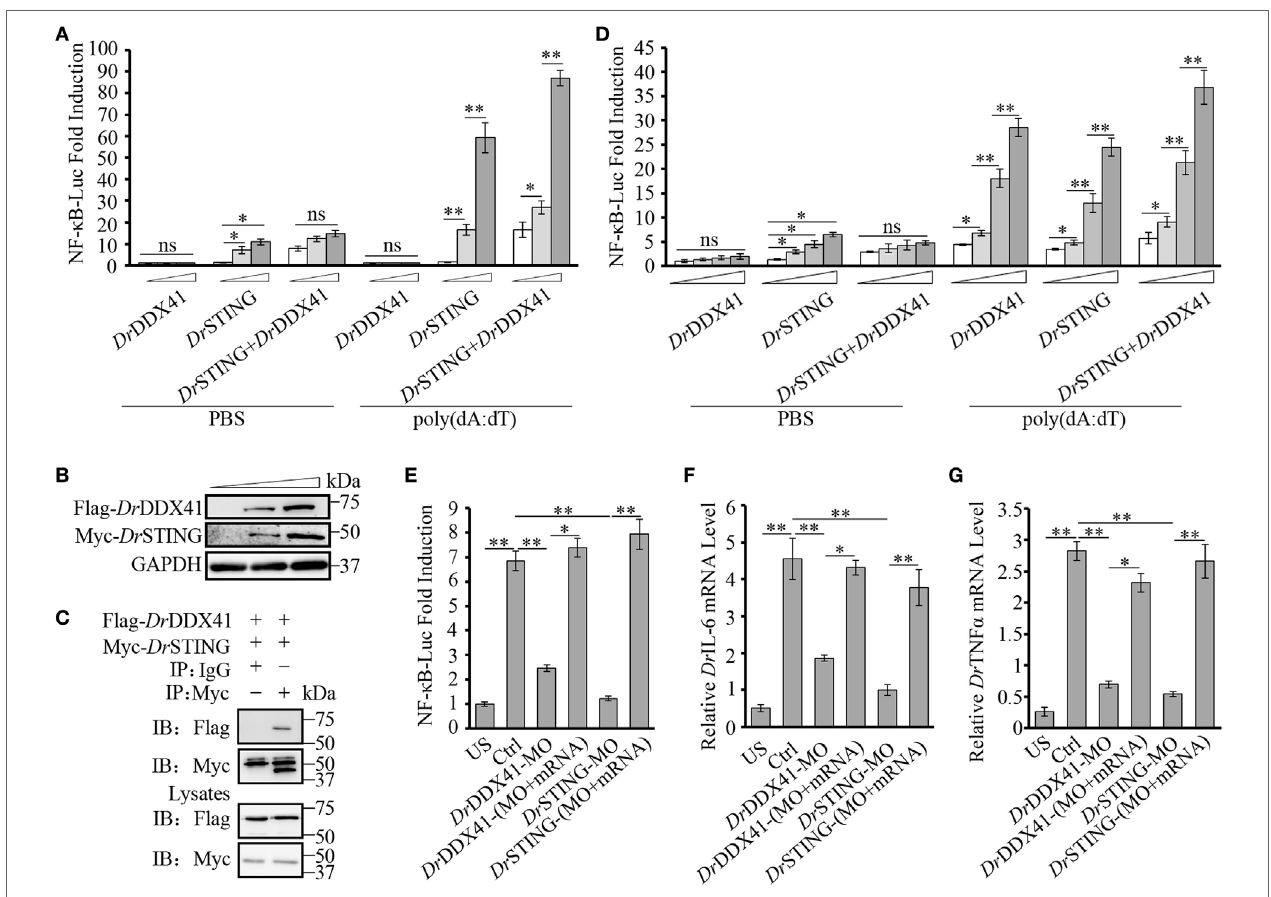
FigUre 6 | Involvement of Danio rerio DDX41 ( Dr DDX41) in nuclear factor- κ B (NF- κ B) signaling pathway. (a) Activation of the NF- κ B-binding promoter in HEK293T cells transfected with an NF- κ B luciferase reporter (NF- κ B-Luc; 150 ng/mL), a renilla luciferase reporter (15 ng/mL) plus increasing amounts (0, 200,